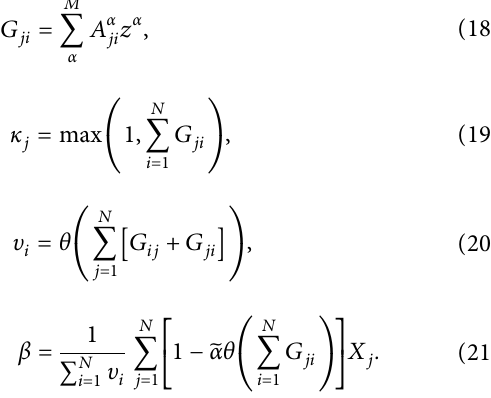
Figure 14 has the following five artistic styles: (1) Color Field Painting (65.93%), (2) Abstract Expressionism (13.19%), (3) Surrealism (12.09%), (4) Expressionism (7.69%), and (5) Minimalism (1.1%). Figure 14(a)